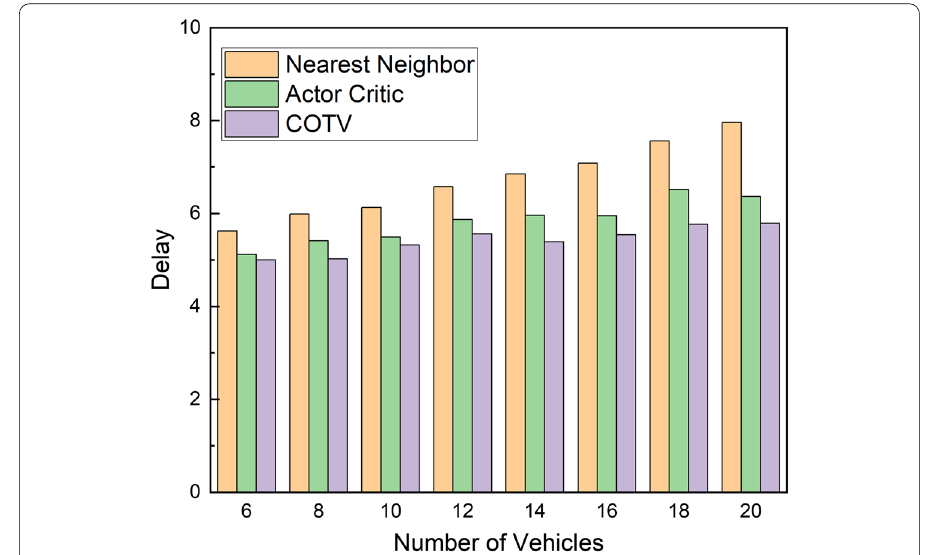
Fig. 8 Delay versus number of